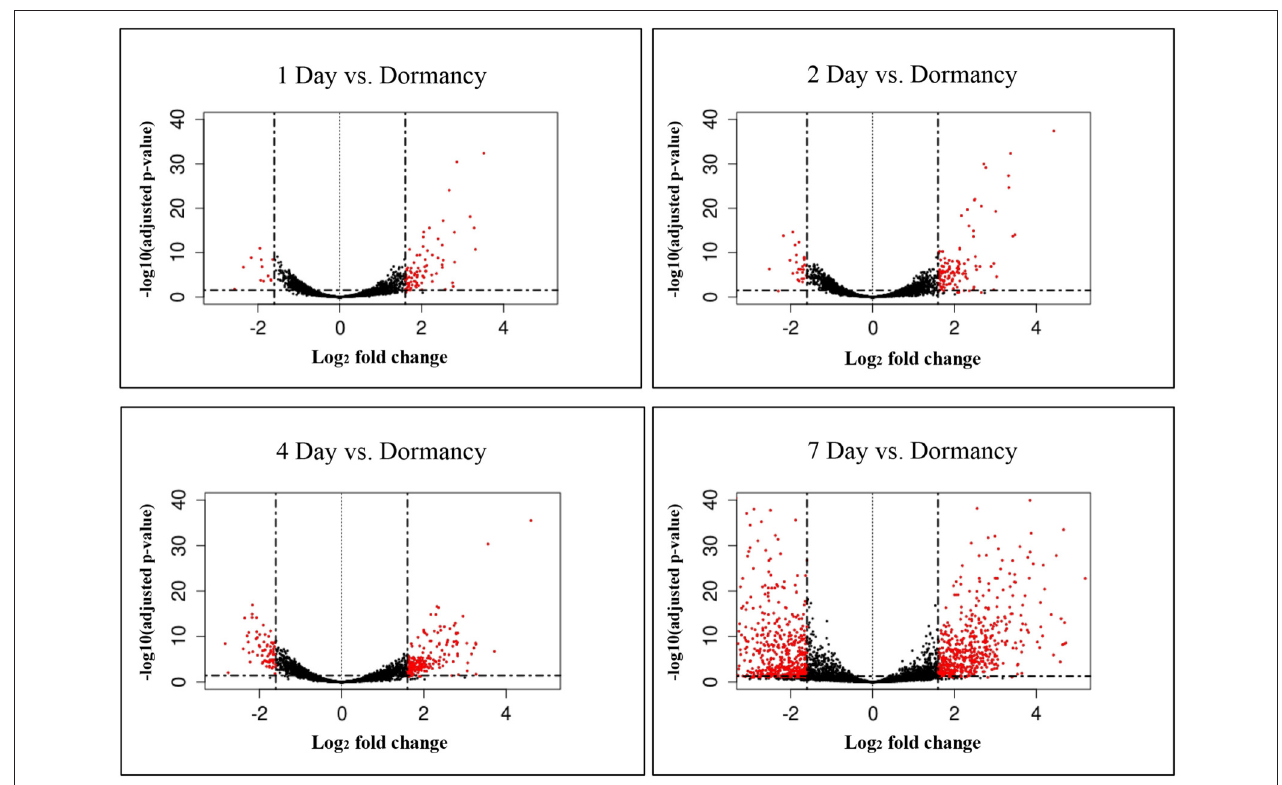
FIGURE 3 | Volcano plots of differentially expressed genes. Fold changes between genes were plotted. Criteria of > 3 x change (log2FC > 1.6) in expression and < 0.1 p-adj-value were used to define significantly changed genes. Differentially expressed genes which met the criteria are shown in red, and those which were expressed at lower levels are shown in